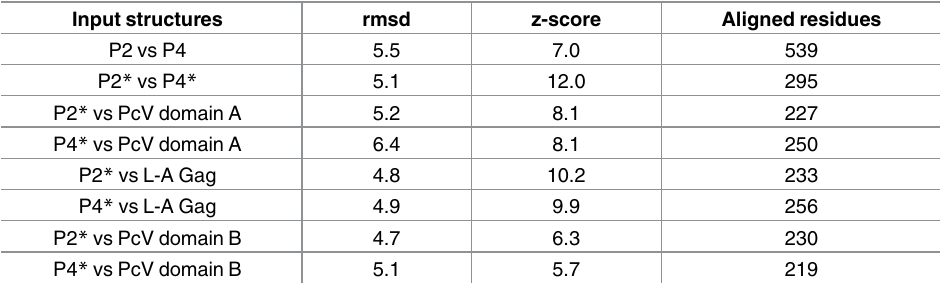
Table 1. Dali-based structural